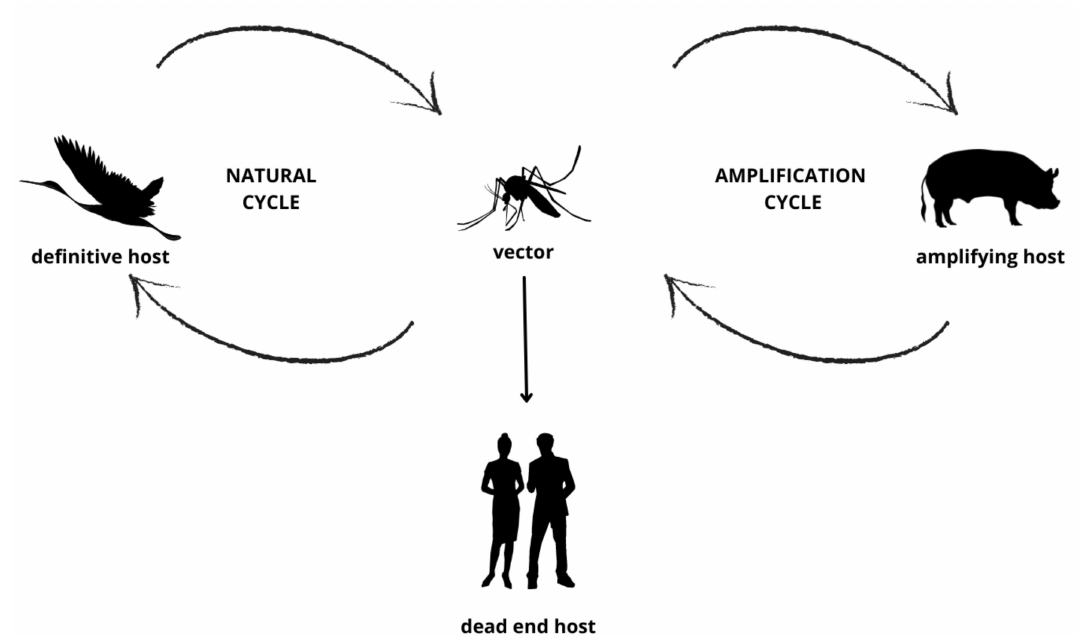
Figure 1. Schematic of Japanese encephalitis virus (JEV) circulation amongst mosquitoes (vectors), wading birds (definitive hosts), pigs (amplifying hosts) and humans (dead end hosts). Of note, humans and other ‘dead end hosts’, for example horses, llamas, dogs, goats, do not develop high- level viraemia and hence carry a minimal risk of transmitting the virus to mosquitoes and hence perpetuating the JEV